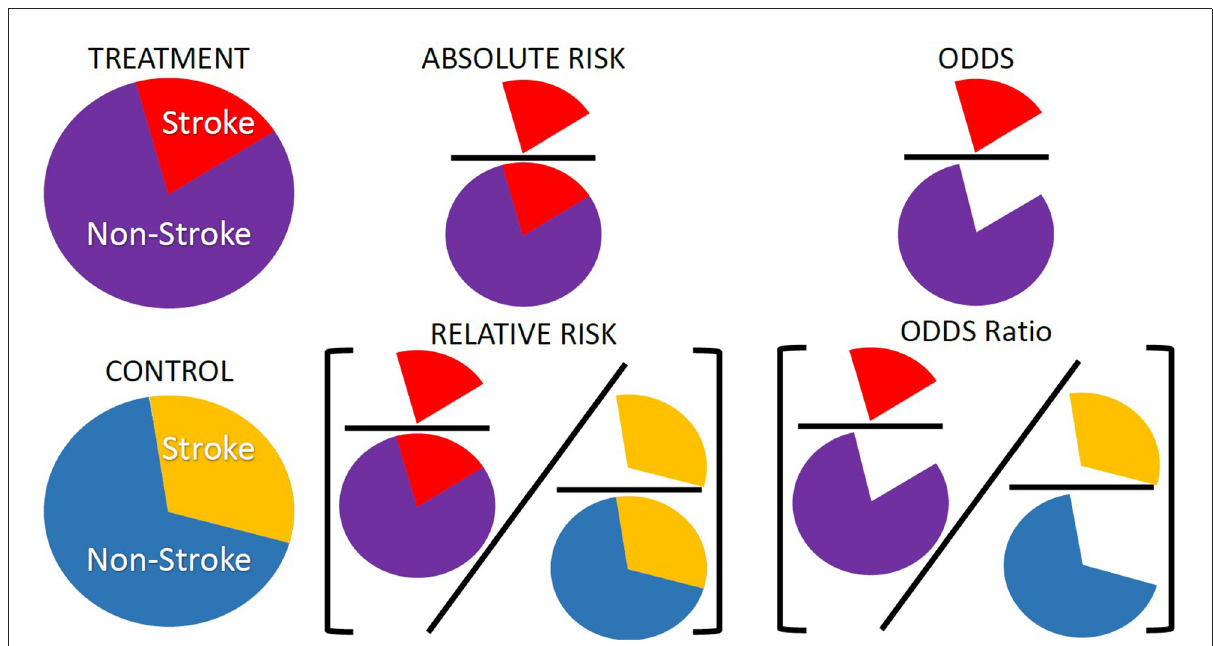
FIGURE1 Representation of absolute risk, relative risk, and odds ratios. These are three of the common risk or association types presented in modeling studies and are often used interchangeably or misinterpreted when there are distinct differences between them. Absolute risk is often presented as a percentage and is the number of individuals with an event, number of strokes, over the total number of individuals in a group, number of strokes and non-strokes. Relative risk is a ratio of absolute risks, often treatment over control. Odds ratios are a measure of association rather than a risk. Odds are the number of times an event occurred in a group, number of strokes, over the number of times the event did not occur, number of non-strokes. Odds ratios are a ratio of two odds, often the ratio of the odds in a treatment group over the ratio of odds in a control